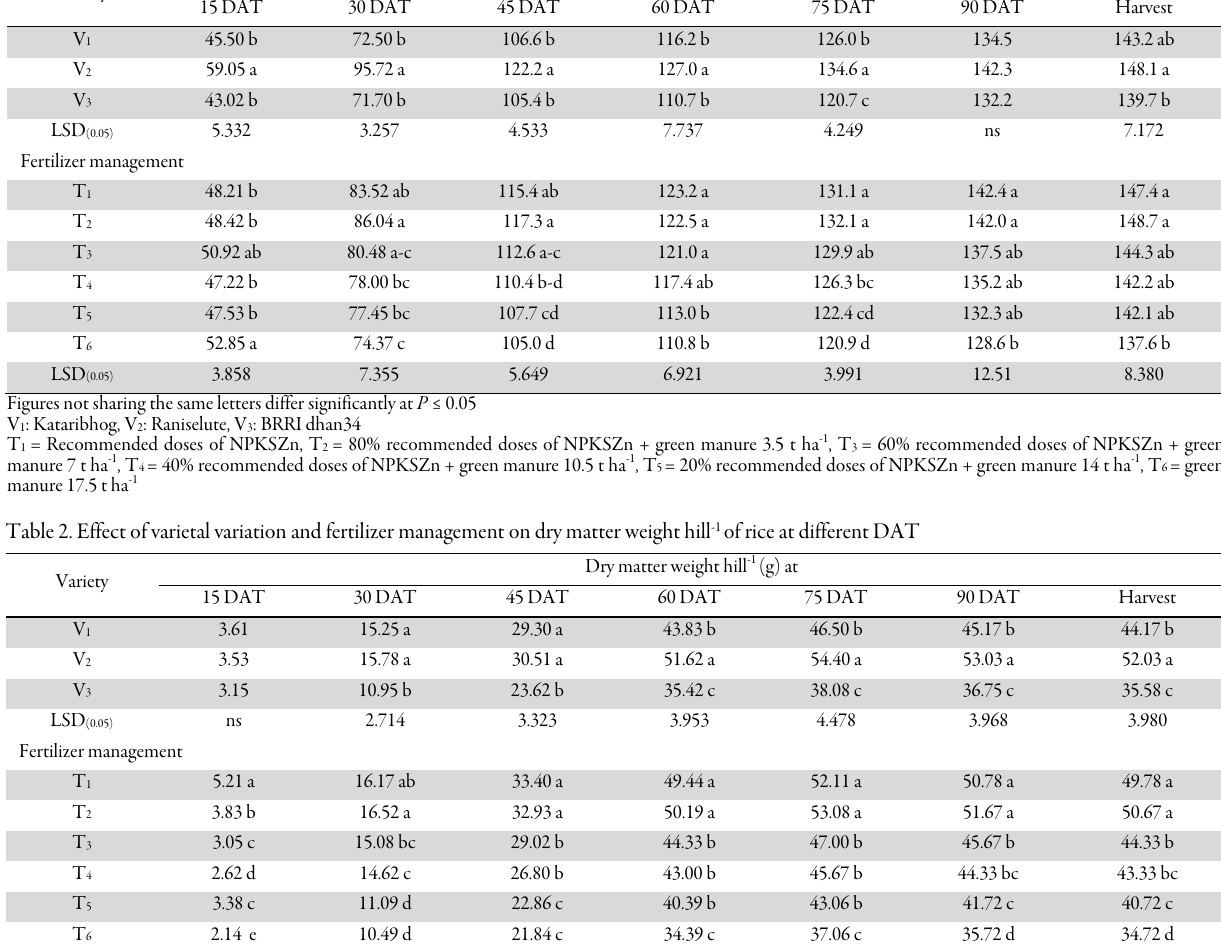
Table 1. Effect of varietal variation and fertilizer management on plant height of rice at different days after transplanting (DAT) Variety